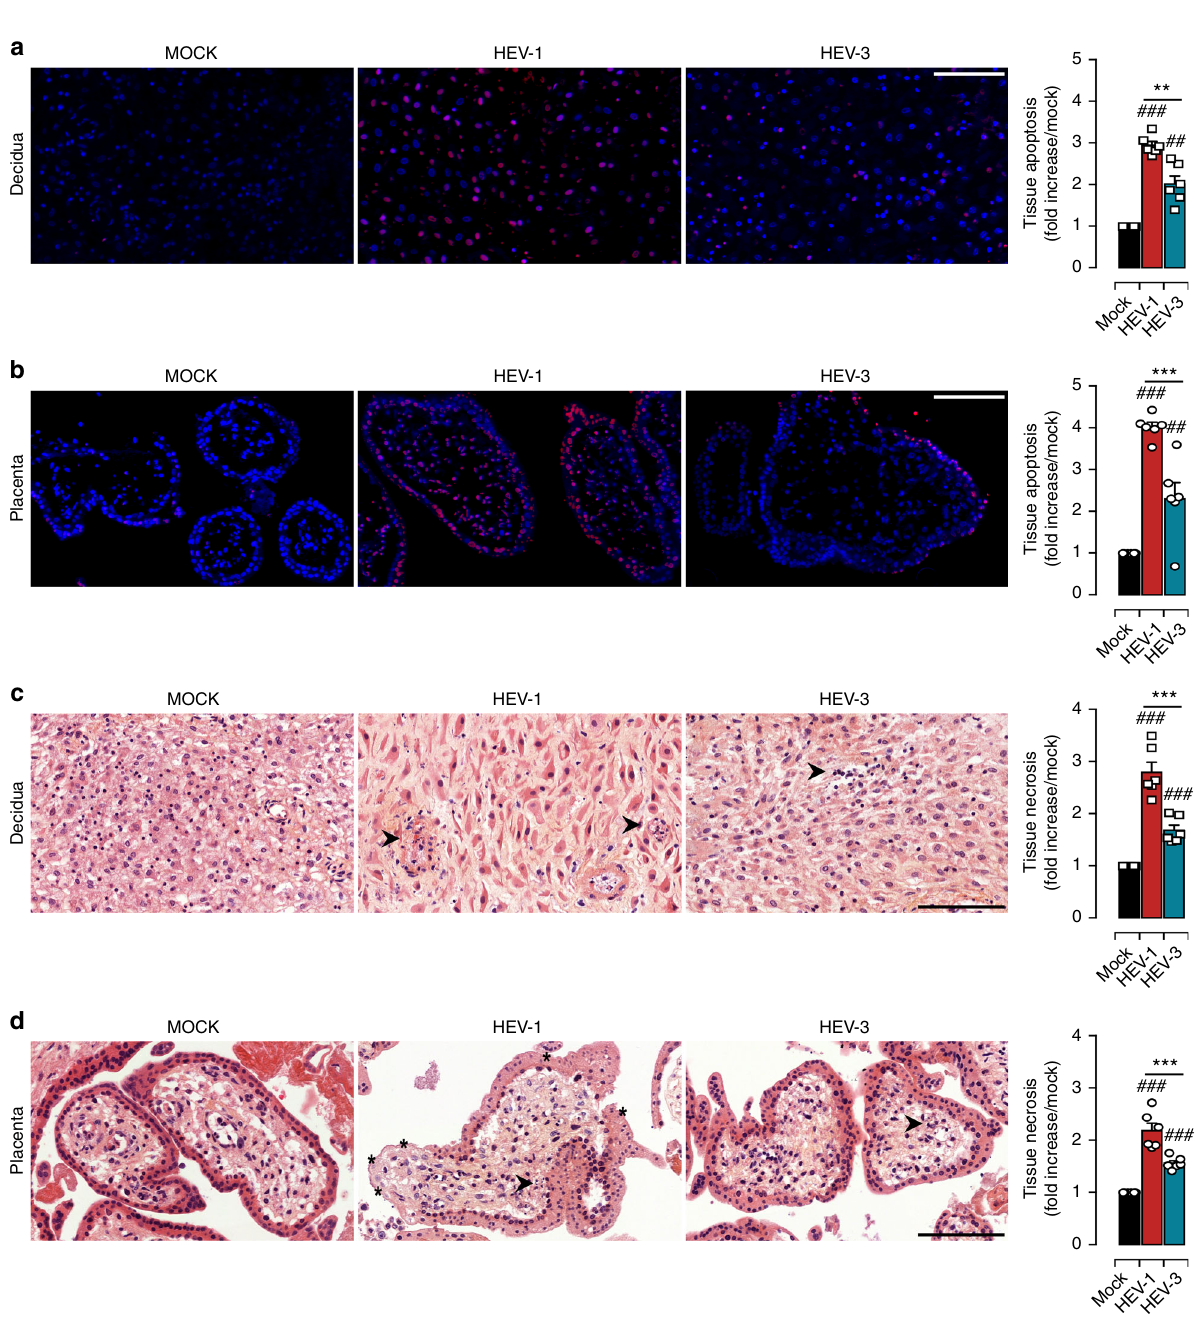
Fig. 2 HEV-1 causes severe injury in decidual and placental tissues. Histological analyses of apoptosis (TUNEL staining, a , b ) and necrosis (H&E staining, c , d ) in explants sections prepared from mock, HEV-1, or HEV-3 infected tissues, 5 days post infection. a , b Representative large fi eld of view of TUNEL stained sections prepared from the decidua a and placenta b . Staining indicates the apoptotic cells (red) and nuclei (blue). Scale bar, 100 µ m. Bar graph illustrates the increase of tissue apoptosis in HEV-1 (red) or HEV-3 (cyan) infected tissue explants, compared to levels detected in mock-infected tissue explants (black) and represented as fold increase. c , d Representative large fi eld of view of H&E stained sections prepared from the decidua c and placenta d . Arrowheads point to necrotic zones with nuclear changes illustrated by pyknosis, karyorrhexis, and karyolysis. Stars indicate an injured syncytiotrophoblast layer. Scale bar, 100 µ m. Bar graph illustrates the increase of tissue necrosis in HEV-1 (red) or HEV-3 (cyan) infected tissue explants, compared to levels detected in mock-infected tissue explants (black) and represented as fold increase. Data represent mean values± S.E.M. of six independent donors. * denotes a statistical comparison between HEV-1 and HEV-3 infected tissues and # represents a statistical comparison between mock and HEV-1 or HEV-3 infected tissues. **/## P < 0.01; ***/### P < 0.001 by repeated measures ANOVA with Tukey post hoc Spearman ’ s ranked correlation test (Fig. 3d). Although, it reached To further visualize the global pattern of soluble factor signi fi cance, the effect of HEV-1 replication on the IL-6 placental production was very low. Unlike HEV-1, only moderate correla- tions were observed between HEV-3 and cytokine production both in a principal component analysis (Fig. 3e). HEV-1 and HEV-3 in the decidua and placenta samples (Supplementary Fig. 2). infected samples naturally clustered into two distinct groups with